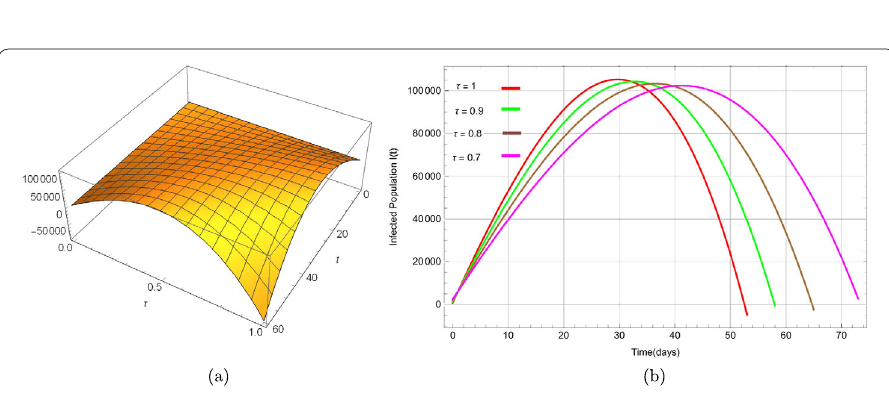
Figure 6 Dynamical behavior of the infected population I ( t ) where ( a ) shows the surface for 0 < τ ≤ 1 and 0 ≤ t ≤ 60 while ( b ) shows infected population with parameters μ = 0.08, σ =